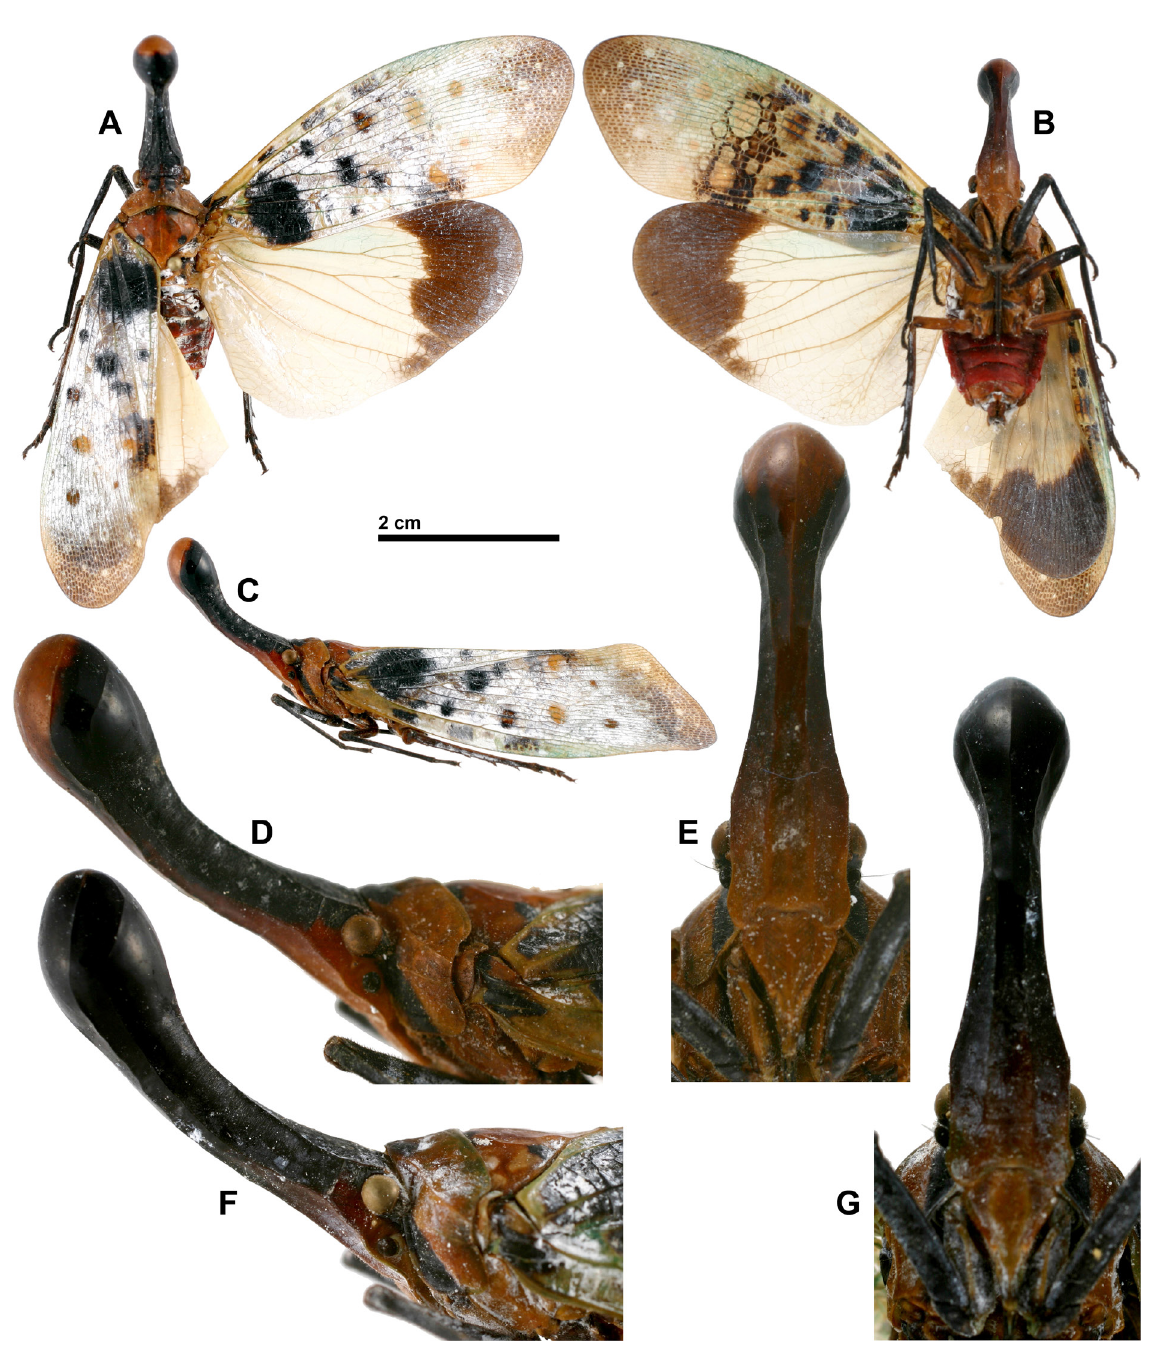
Fig. 2. Pyrops clavatus (Westwood, 1839), ♀♀, Thailand, Chiang Mai, Dec. 2007 (RBINS). A–E . Dark specimen with cephalic process brown ventrally. A . Habitus, dorsal view. B . Habitus, ventral view. C . Habitus, left lateral view. D . Head and thorax, left lateral view. E . Head, normal view of frons. — F–G . Dark specimen with black cephalic process. F . Head and thorax, left lateral view. G . Head, normal view of frons. (D–G not to